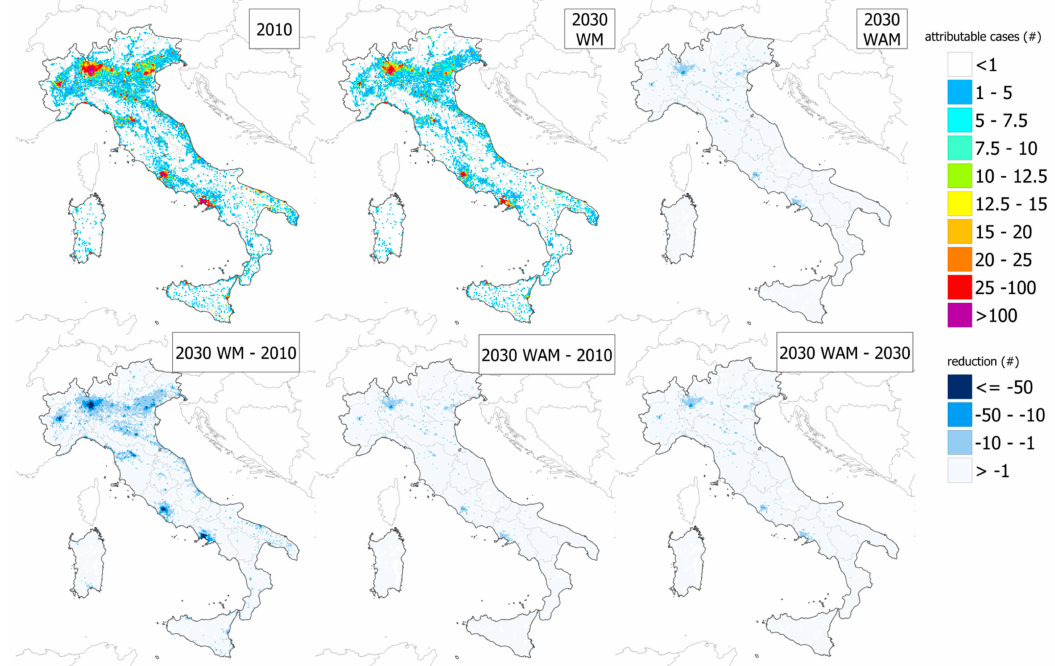
Figure 1. PM 2.5 mortality (number of deaths) in 2010 ( upper left ), 2030 WM ( upper center ), 2030 WAM ( upper right ), variation in mortality between 2010 and 2030 WM ( lower left ), 2010 and 2030 WAM ( lower center ), and 2030 WM and 2030 WAM ( lower right